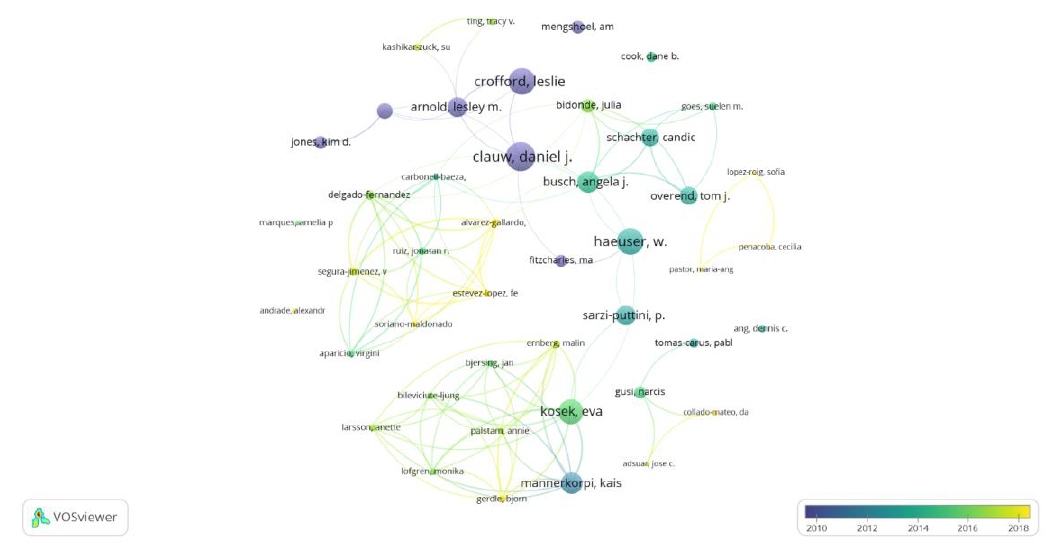
Figure 4. Most prolific co-authors.